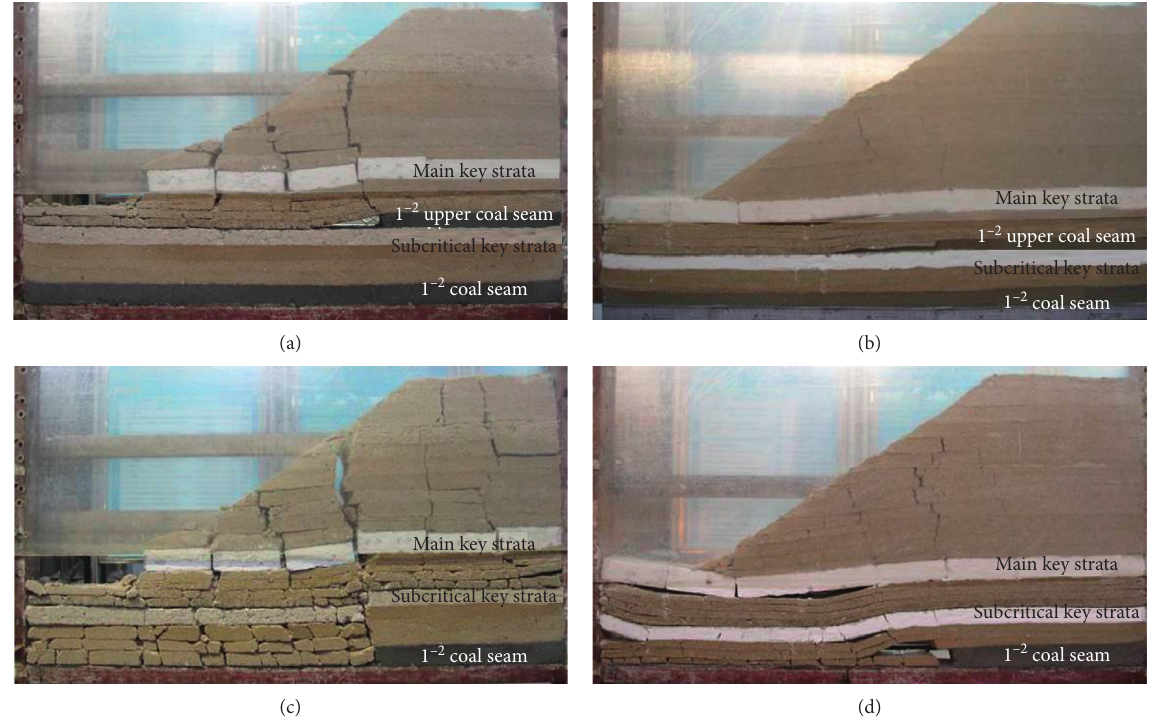
Figure 7: Comparison of main key strata absence and nonabsence recovery situation of 1 − 2 upper coal and 1 − 2 coal. (a) Absence of main key strata of 1 − 2 upper coal seam mining. (b) Nonabsence of main key strata of 1 − 2 up coal seam mining. (c) Absence of main key strata of 1 − 2 coal seam mining. (d) Nonabsence of main key strata of 1 − 2